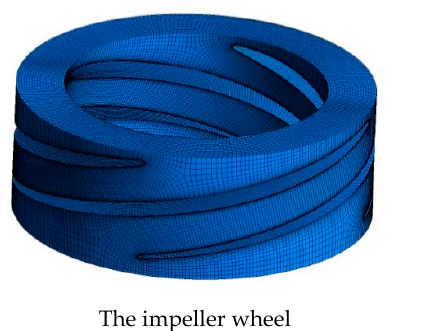
Figure 4. Mesh generation of supercharged unit.